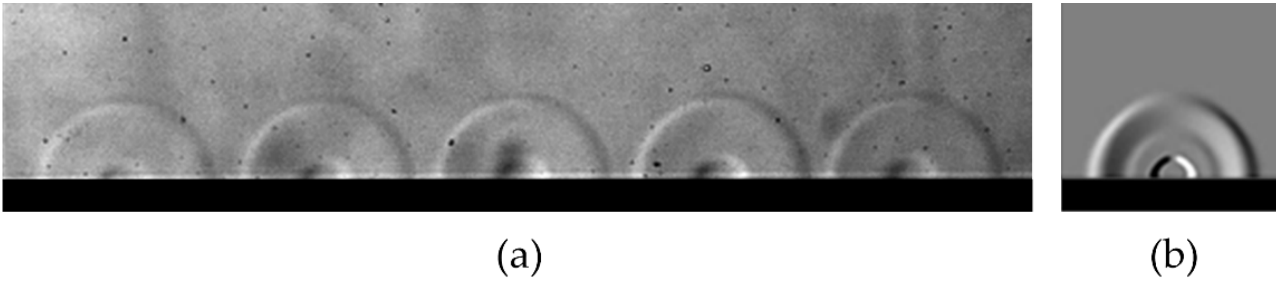
Figure 9. Plasma actuation evolution: ( a ) experimental schlieren; ( b ) numerical schlieren.